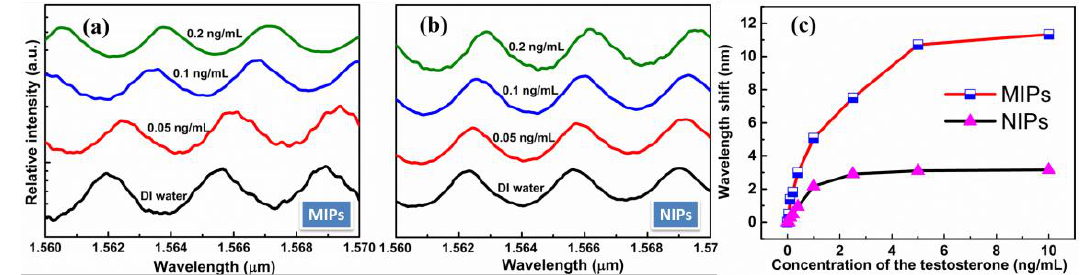
Figure 4. ( a ) Transmission spectra of molecularly imprinted polymer films (MIPs) when